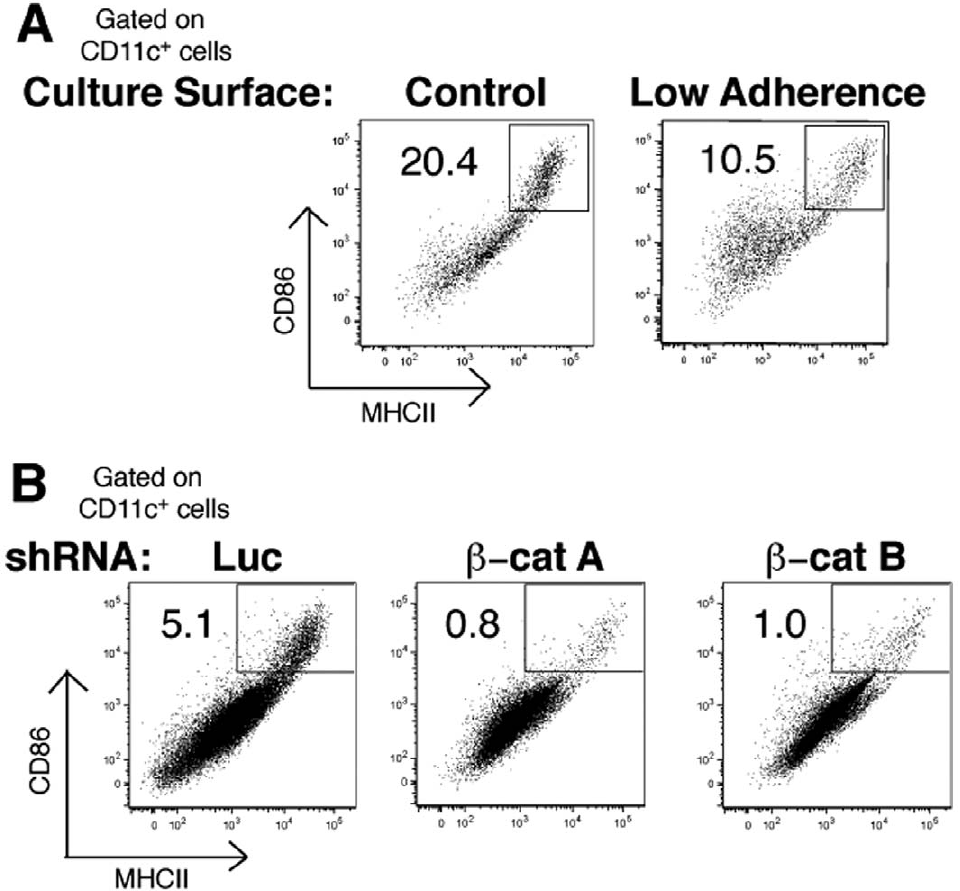
Figure 3. Signals Associated with Tolerogenic Function are Constitutively Active. (A) BMDCs were cultured for 5 days on standard tissue culture treated plates or on low adherence plates (hydrogel-coated, Invitrogen) and then analyzed for maturation status by flow cytometry. Gates are drawn on CD11c + MHCII hi /CD86 hi mature cells. (B) BMDCs were infected with luciferase or b -catenin shRNA as in Fig 2 and cultured for 7 days post- infection before maturation status was assessed by flow cytometry. Mature cells are identified as in (A). Numbers indicate percent within mature gate. Data from parts A&B are representative of at least 3 repeats.